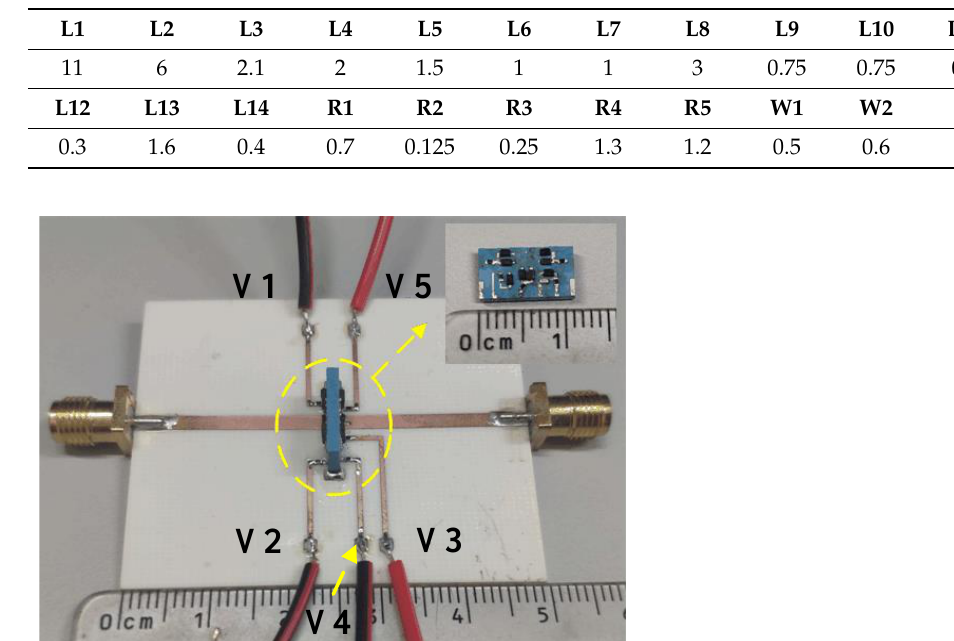
Table 1. The dimensions (mm) of the designed filter.